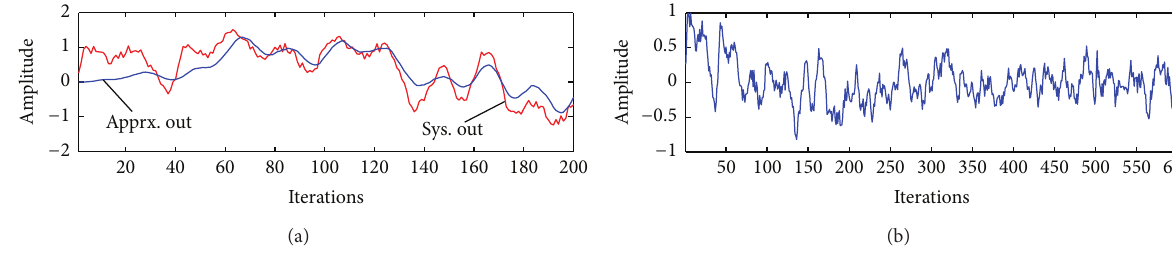
Figure 12: The simulation result with LMS algorithm. (a) Process of identification. (b) Error of identification.